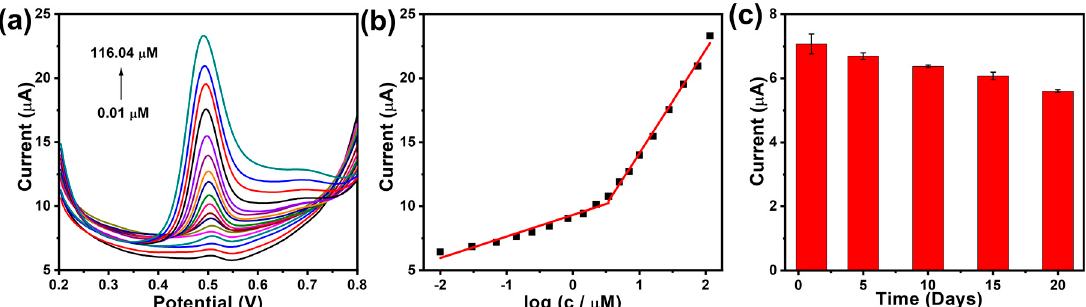
Figure 6. DPVs ( a ) of different concentrations of BPA at MI-Au-MoO 3 /rGO electrode in 0.1 M phosphate buffer (pH 7.0). The relationship between peak current and log C ( b ). Peak currents of 10 µ M BPA on MI-Au-MoO 3 /rGO electrode for 20 days ( c ).